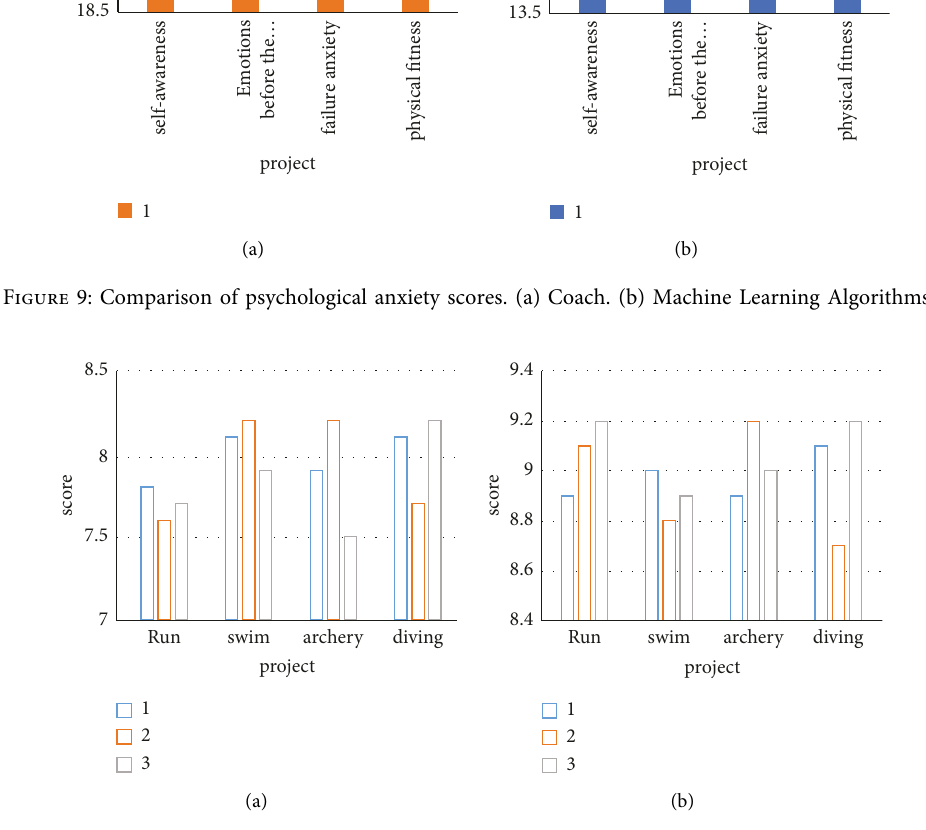
Figure 10: Comparison of performance before and after regulation. (a) Before regulation. (b) After